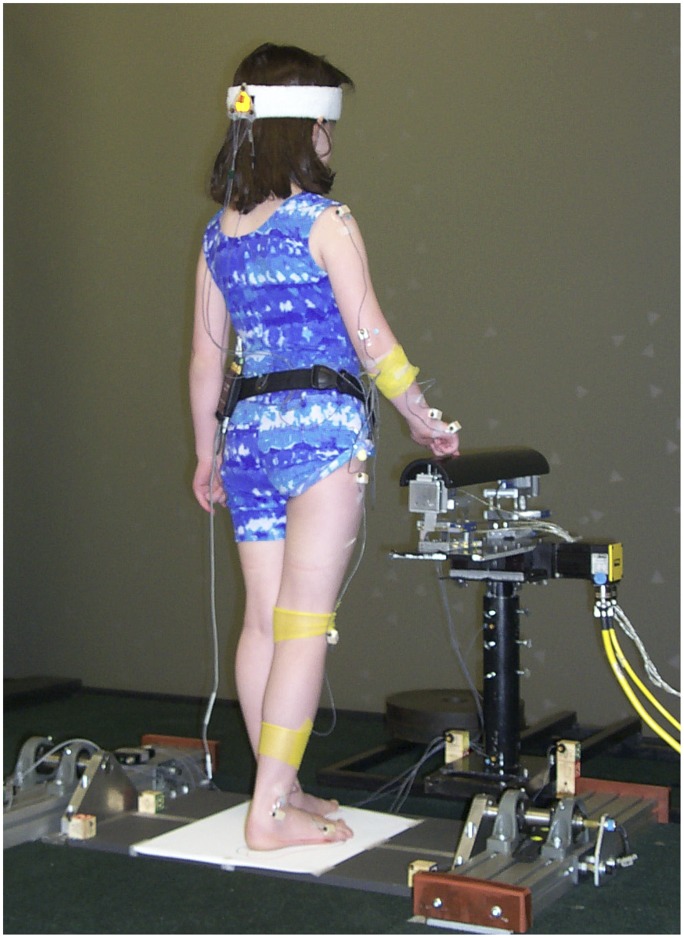
Experimental set-up showing a child performing the multisensory posture task.The child stood in a modified semi-tandem stance looking at a front screen with random dots projection (not shown due to room illumination) while touching a bar lightly without triggering an auditory alarm. Both the visual display and the touch bar moved in the mediolateral direction simultaneously but with different frequencies. Markers were placed on the head and on the right side of the arm, and lower leg to track postural kinematics.